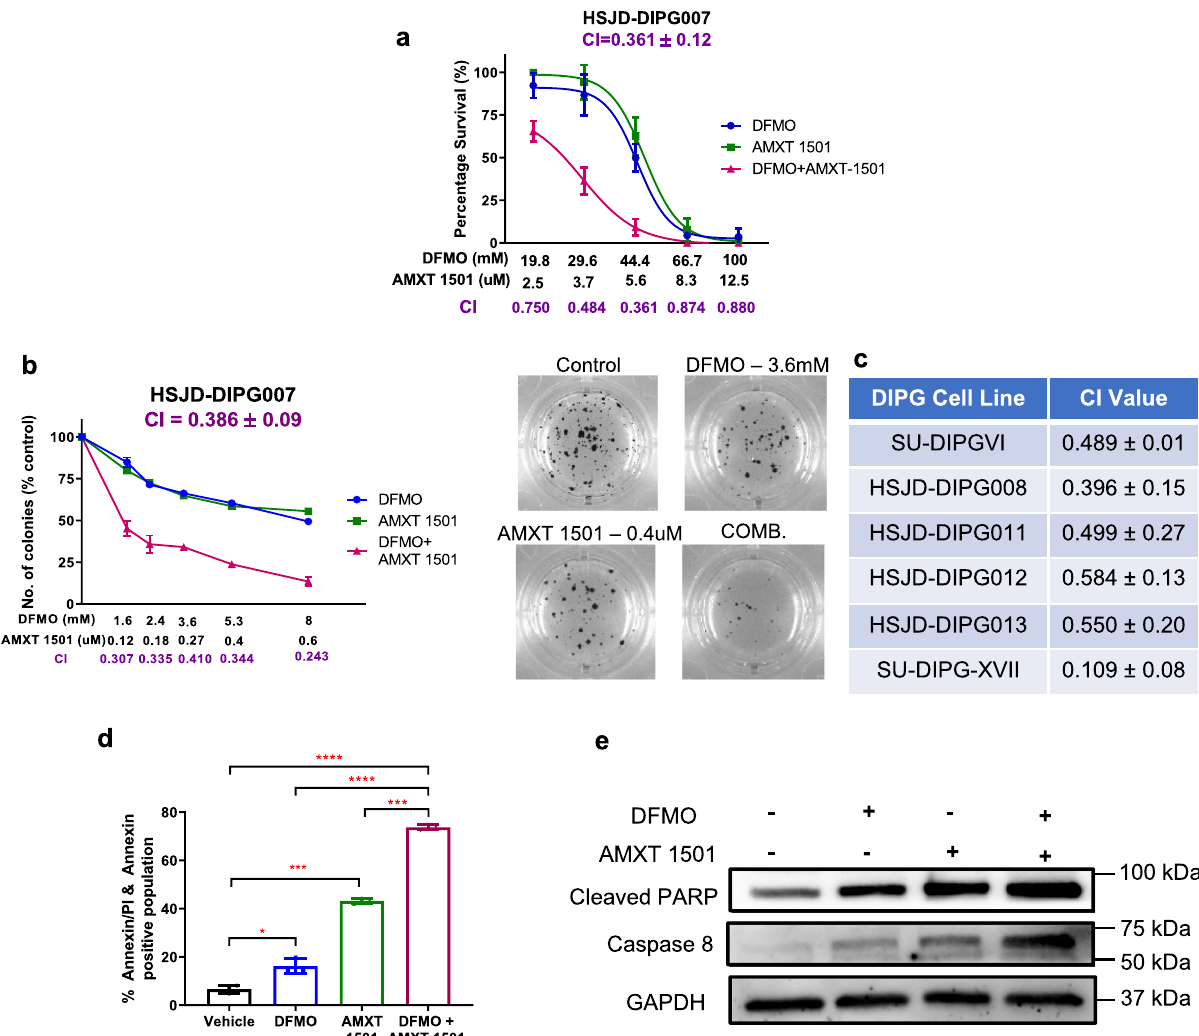
Fig. 4 The effect of combined inhibition of polyamine synthesis and uptake, using DFMO and AMXT 1501, on cell proliferation, colony formation and apoptosis. HSJD-DIPG007 cells have synergistically decreased ( a ) cell survival and ( b ) form fewer colonies, upon combination treatment. c Synergy scores, calculated by Calcusyn, across a panel of neurosphere-forming DIPG cells treated with combination of both agents. d Annexin/PI staining of HSJD- DIPG007 cells treated with 40 mM DFMO, 5 µ M AMXT 1501 or combination of both agents for 24 h. Vehicle vs DFMO: p = 0.0221, Vehicle vs AMXT 1501: p = 0.0003, Vehicle vs DFMO + AMXT 1501: p < 0.0001, DFMO vs DFMO + AMXT 1501: p < 0.0001, AMXT 1501 vs DFMO + AMXT 1501: p = 0.0005. e Apoptotic effects of DFMO and AMXT 1501 combination on protein expression of cleaved PARP and caspase 8. Representative blot from two independent experiments. Data are presented as mean values ± SEM of three independent experiments. a , b n = 3 wells examined over three